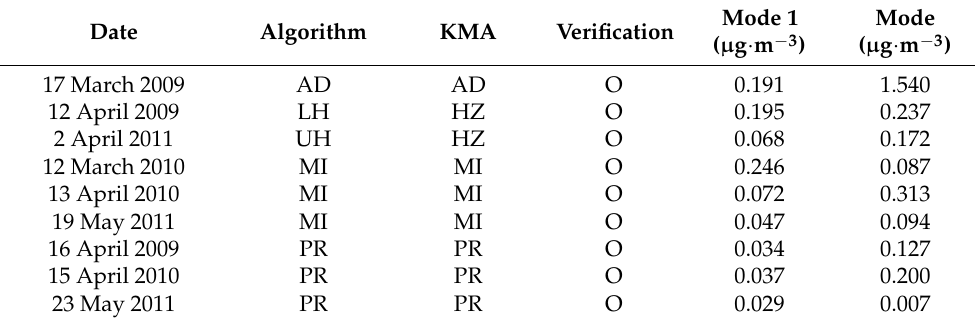
Table 5. Meteorological phenomena observed by the KMA, and the corresponding results derived from the classification